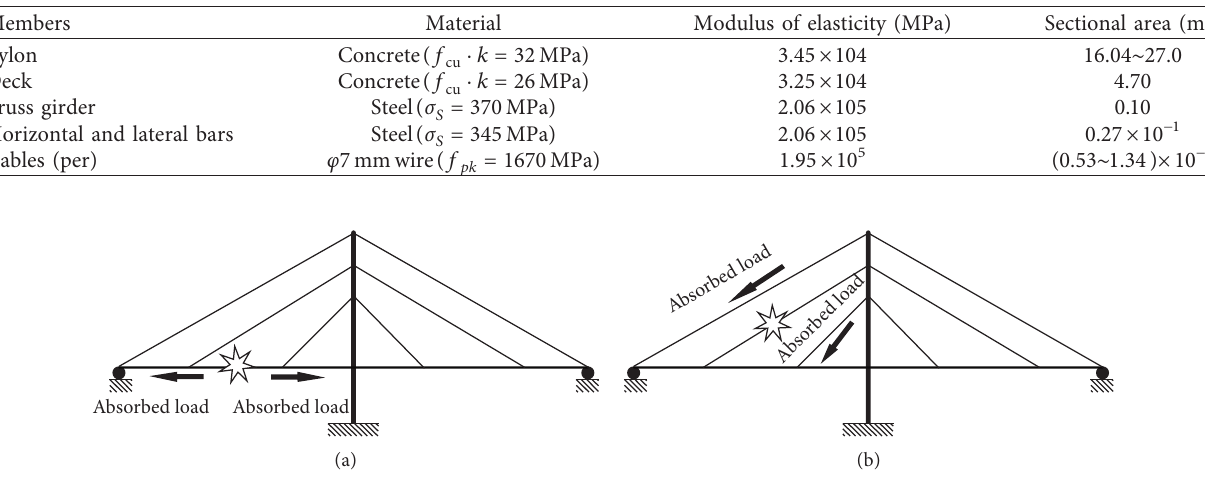
Table 1: Material properties of the cable-stayed bridge.